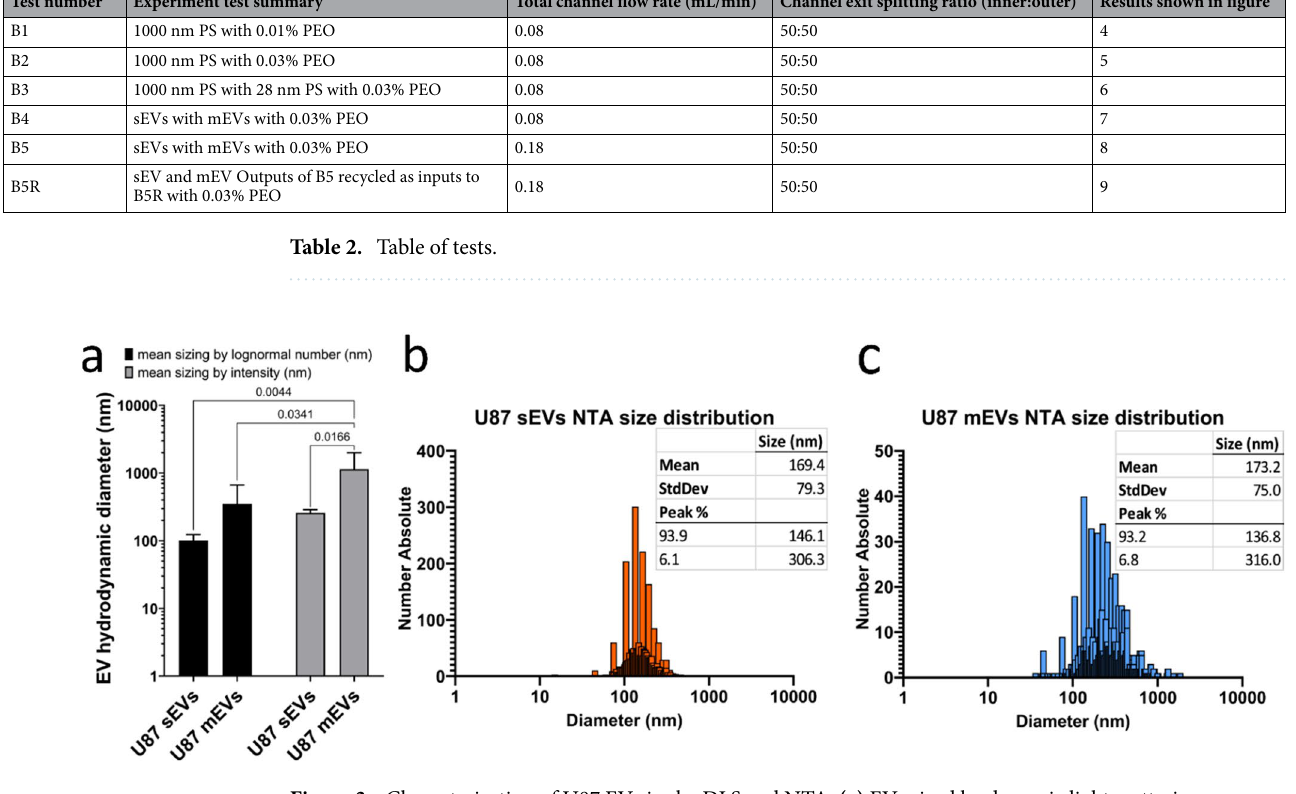
Figure 3. Characterization of U87 EV size by DLS and NTA. (a) EVs sized by dynamic light scattering using two different sizing modalities. Lognormal number detects the more numerous, smaller trending subpopulation of EVs in an EV pool, whereas intensity detects the larger sized subpopulation within an EV pool, error bars = SD (n = 6). Using 2-way ANOVA with p-values < 0.05 considered to be statistically significant, EV sizes were compared by type (sEV versus mEV, p = 0.007) and by DLS sizing modality (lognormal number versus intensity, p = 0.02). Tukey’s Honest Significant Difference test was used post-hoc for multiple intra- and intergroup comparisons and p values < 0.05 are listed above interconnecting drop-down lines connecting bar plots. (b) sEV and (c) mEV size distributions determined by ZetaView nanoparticle tracking analysis including descriptive statistics